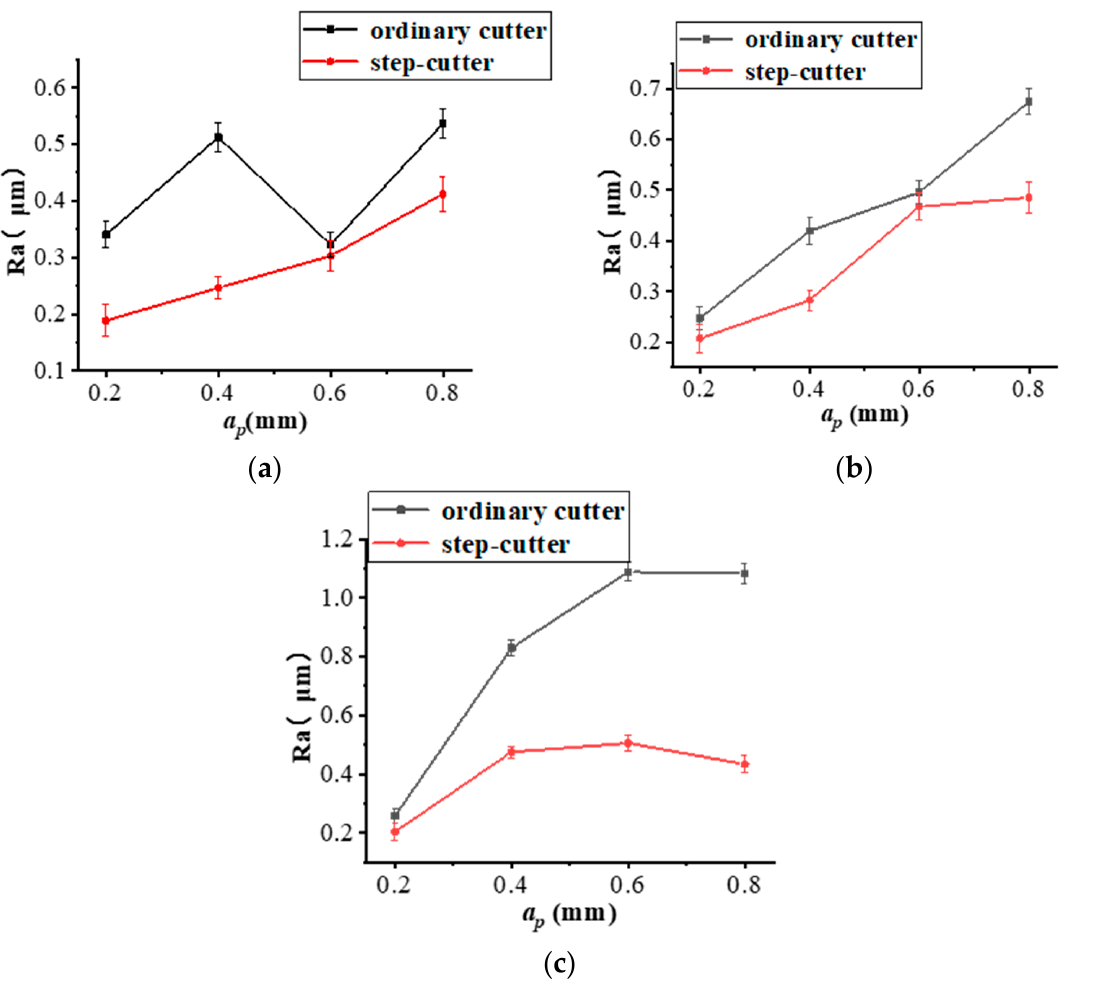
Figure 20. Roughness of helical milling holes surface with ordinary cutter and step-cutter. ( a ) n = 1000 r/min. ( b ) n = 2000 r/min. ( c ) n = 3000 r/min.